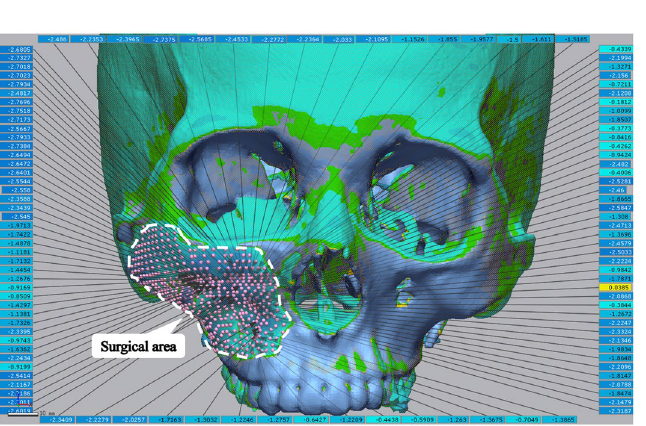
Figure 4. Different stages of the intraoperative guidance: ( a ) When the drill is still at a large distance from the designed surface (> 1 mm), the model is rendered in green, and real-time data will be displayed. ( b ) When the drill is about to reach the designed surface (≤ 1 mm), the model is rendered in red, and real-time data will be displayed.